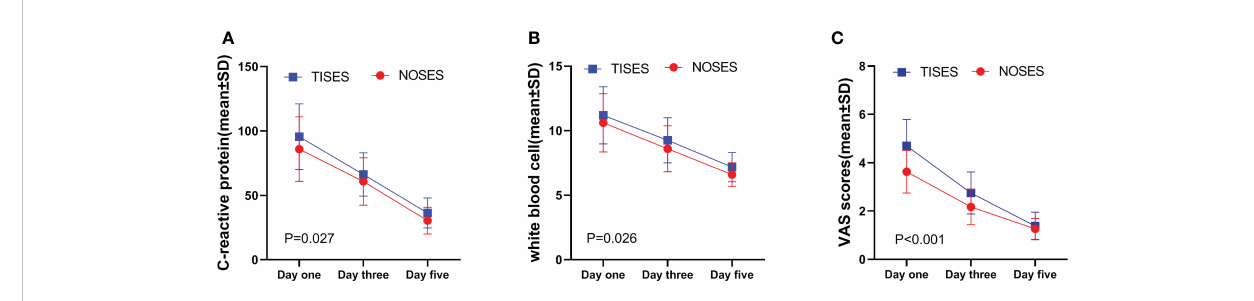
FIGURE 2 Comparison of postoperative CRP levels (A) , WBC (B) , and VAS score (C) in the two